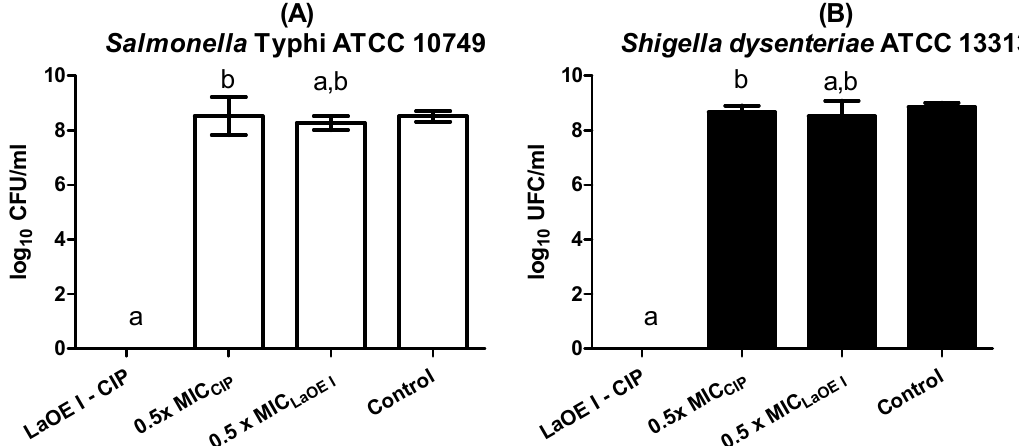
Figure 6. Modulatory effect of LaEO I on the antimicrobial activity of ciprofloxacin on Salmonella typhi ( A ) and Shigella dysenteriae ( B ) mature biofilm. Values are expressed as the mean ± SEM of two assays, in triplicate. The analysis was performed by ANOVA, with Dunnett’s post-test and a p value < 0.05 when compared to the control (a) and a p value < 0.05 when compared to the CIP+LaEO association (b). Control: culture medium + microorganism.